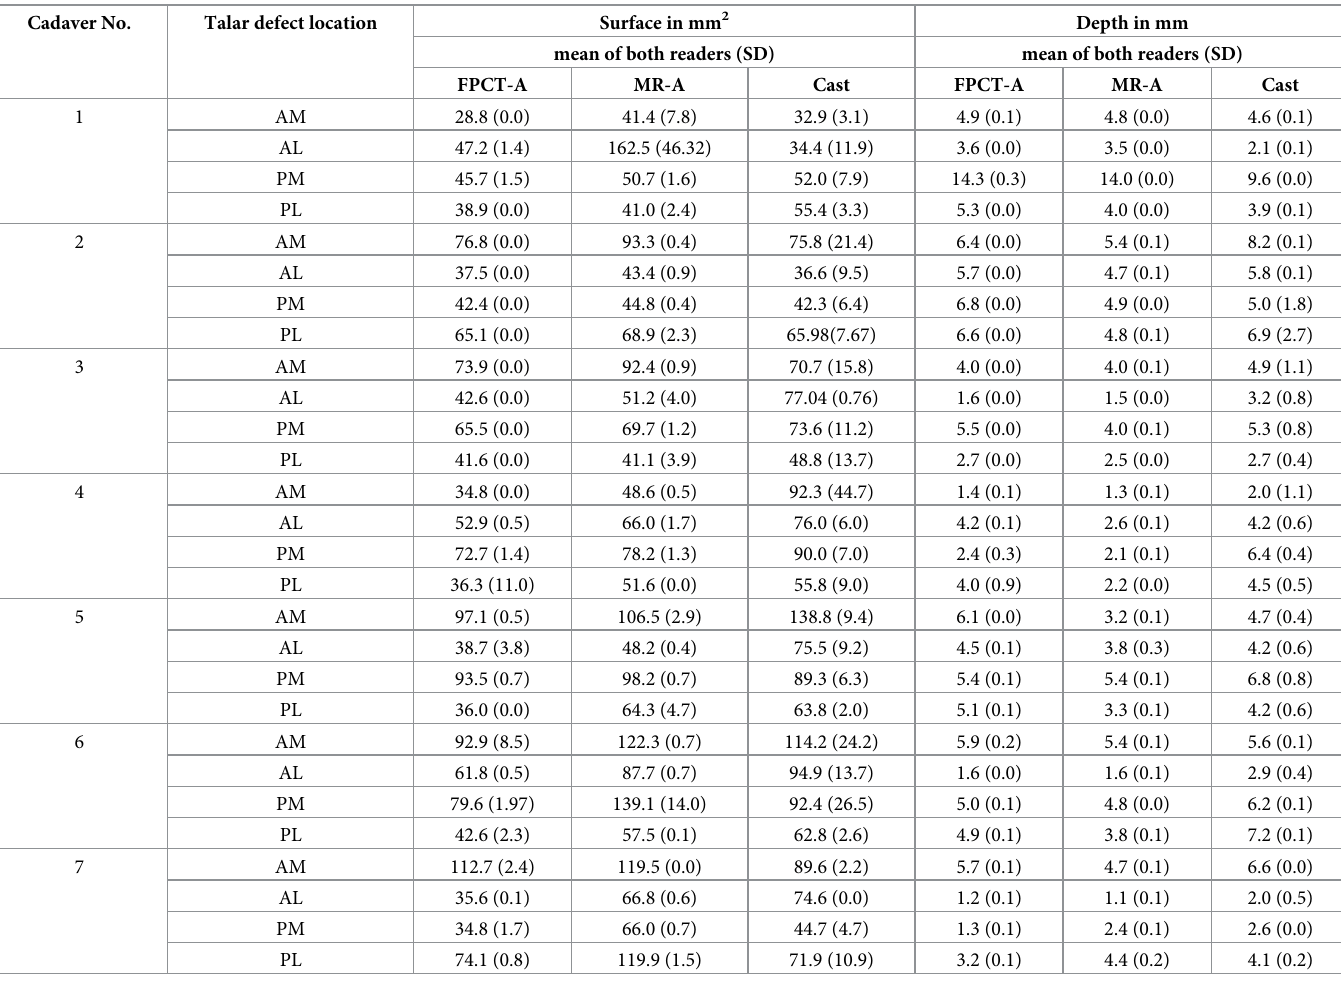
Table 2. Defect measurements cadavers